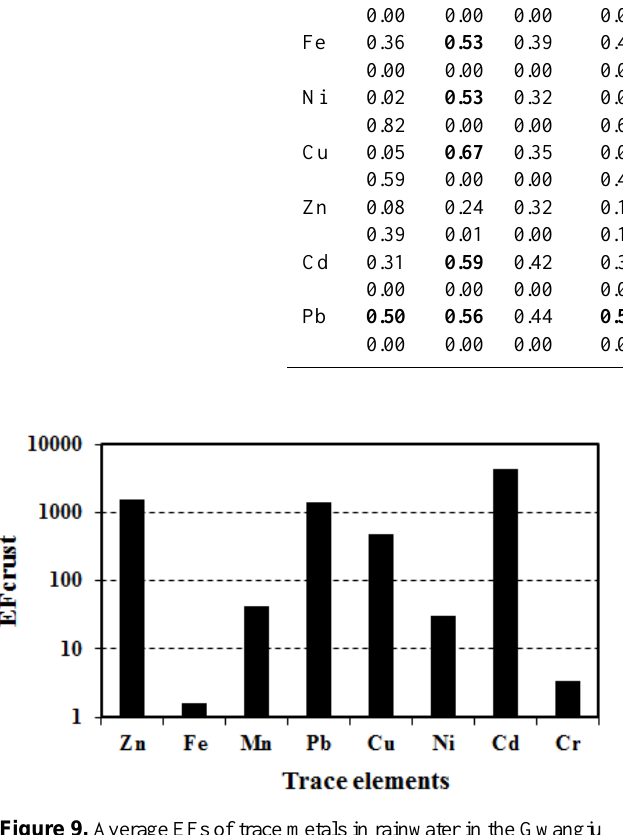
Figure 9. Average EFs of trace metals in rainwater in the Gwangju area during 2012.